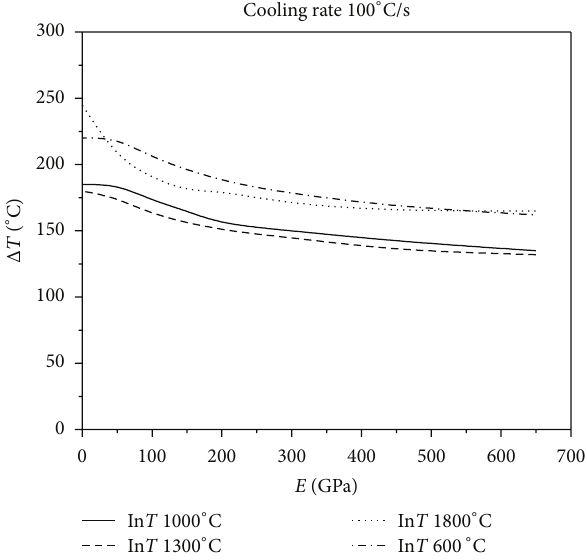
Figure9:Relationshipbetweencriticalfracturetemperaturescorre- sponding to different thermal shock initial temperature and Young’s modulus of constraint material under the cooling rate 2000 ∘